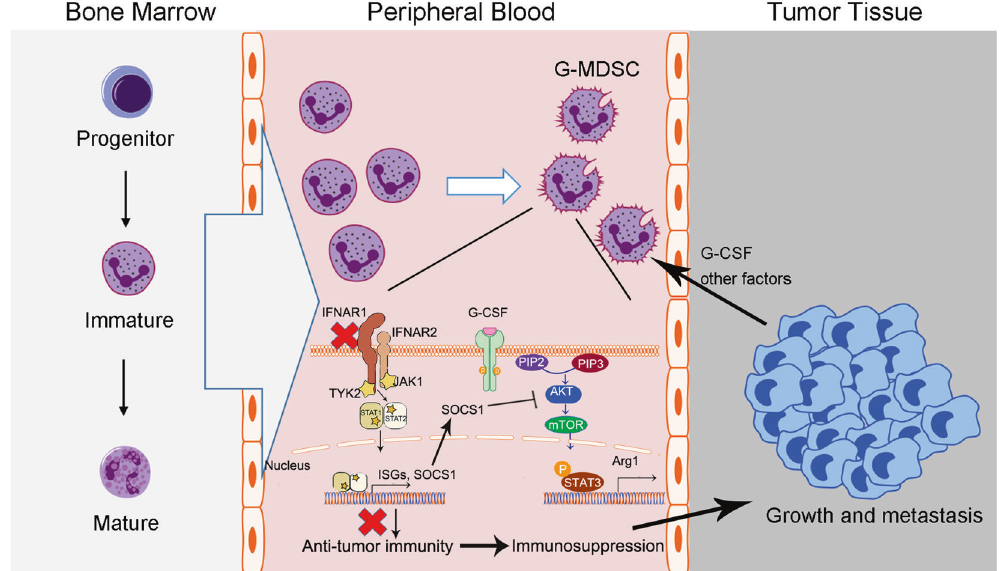
Fig. 8 Schematic illustration of the proposed model. G-MDSCs abnormally expanded under tumor conditions obtain immunosuppressive functions in peripheral blood and ultimately promote tumor growth and metastasis. The activation of PI3K-Akt/mTOR pathway is related to the immunosuppressive function of G-MDSCs. The downregulation of IFN-I signaling in G-MDSCs leads to the activation of PI3K-Akt/mTOR pathway. SOCS1, which depends on IFN-I signaling, regulates the activation of PI3K-Akt/mTOR pathway by directly interacting with